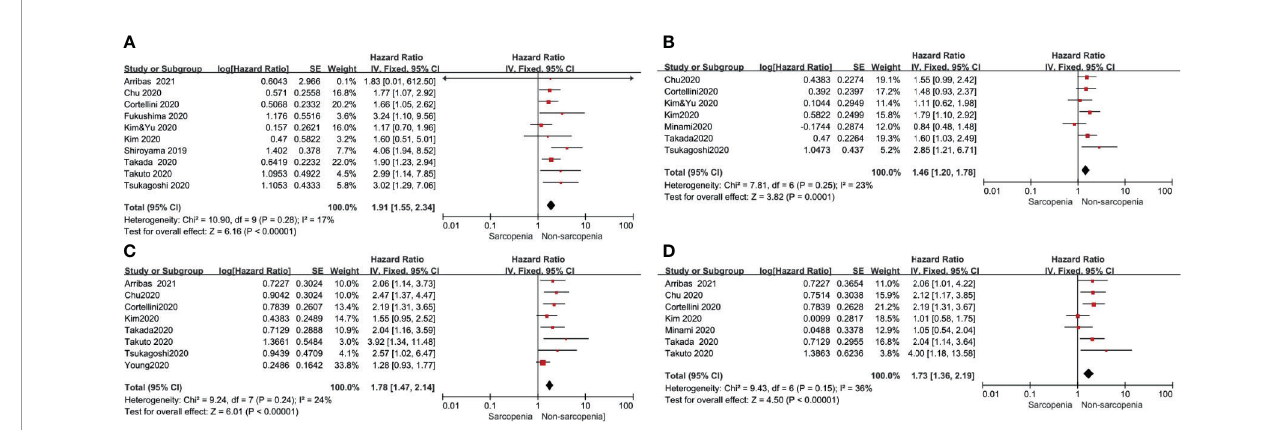
FIGURE 2 | Forest plot of impact of sarcopenia on clinical ef fi cacy. (A) Sarcopenia and PFS(by univariate HR), (B) Sarcopenia and PFS(by multivariate HR), (C) Sarcopenia and OS(by univariate HR), (D) Sarcopenia and OS(by multivariate HR).